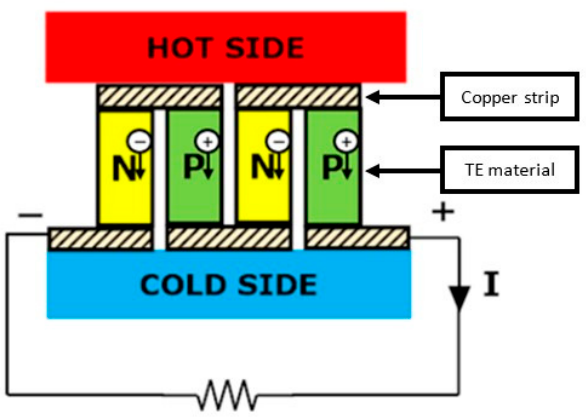
Figure 3. The p - and n -type TE materials placed between the cold side and the hot side. As the temperature between the junction changes, the electron at the end of the n - type material closest to the heat source gains energy. At the end of the n -type element closest to the heat source, the electron concentration is greater than at the end of the cold side. The electron at the heat source end will move to the cold side end, similar to how heat travels from a hot region to a cold region [60]. The same applies to the holes in the p - type elements.